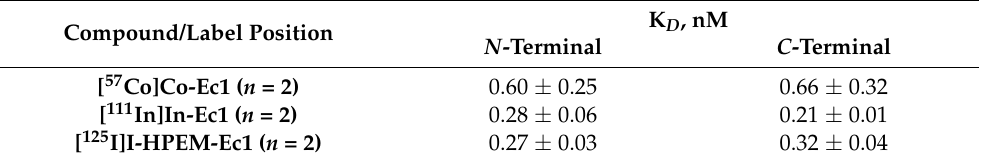
Table 4. Dissociation equilibrium constants (K D ) for the interaction between Ec1 variants labeled with [ 57 Co]Co, [ 111 In]In and [ 125 I]I-HPEM at N - or C -terminus, and DU145 prostate cancer cells. Compound/Label Position